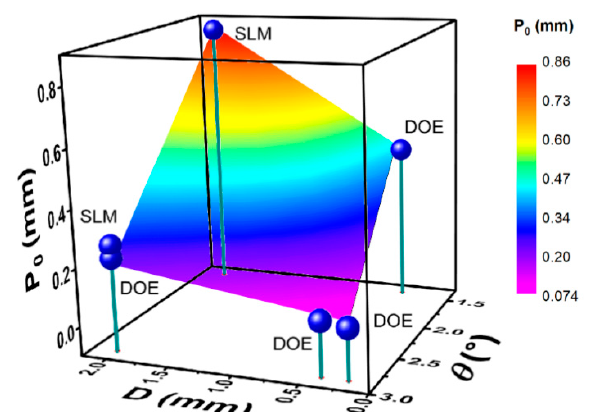
Figure 8. Axial rotation periods P 0 of the spectral eyes as a function of conical beam angle θ and element diameter D (DOE = fixed spiral grating, SLM = programmable spatial light modulator). It is indicated that both parameters can be used to control the spectral Gouy rotation.